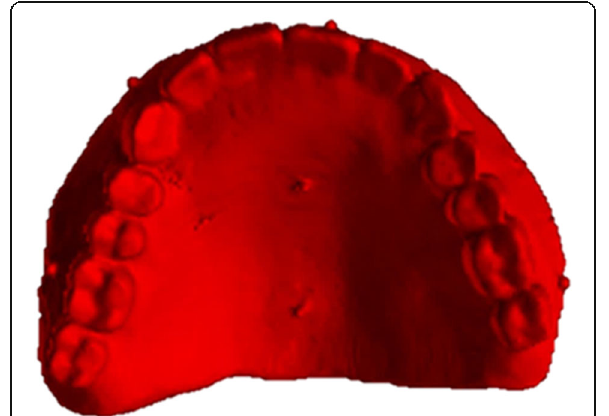
Fig. 1 CBCT scan of existing denture